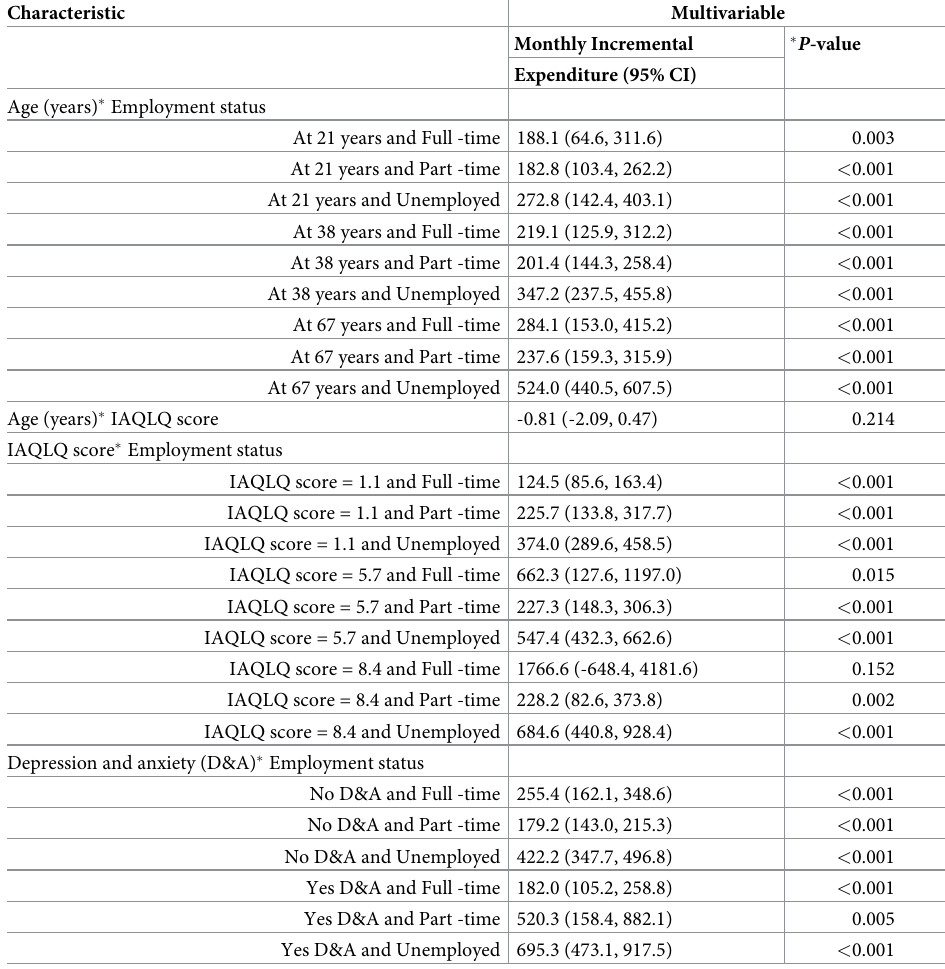
Table 3. Results from interaction